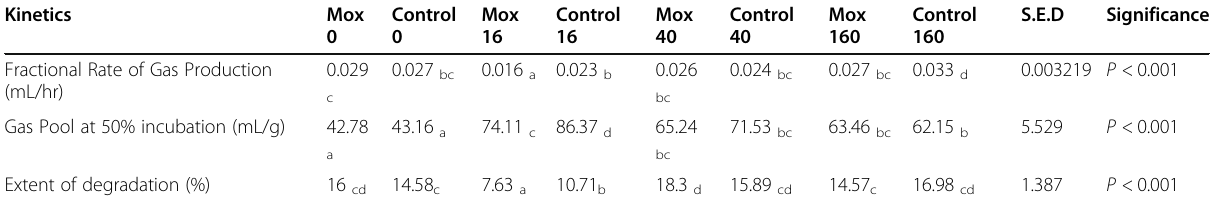
Table 1 Kinetic profiles from the in vitro gas production of hay comparing the moxidectin treated group with the control group at each of the four sampling time